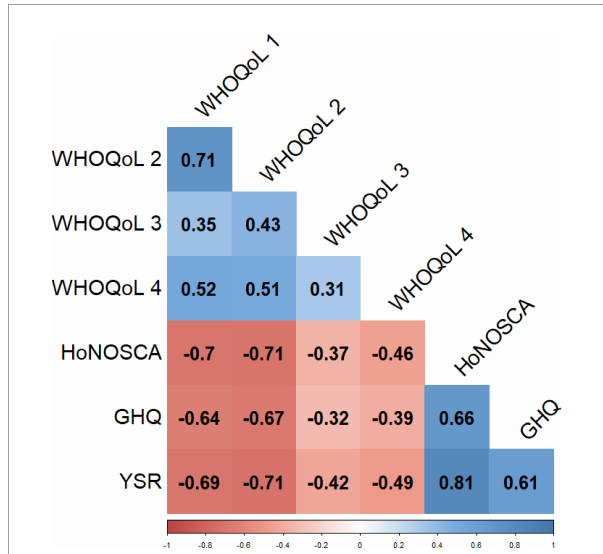
FIGURE3 Correlation matrix between WHO-QoL, HoNOSCA, GHQ, and YSR. Correlation coefficient, method = Spearman’s rho; all coefficients are bold because they are statistically significant ( p < 0.05). GHQ, General Health Questionnaire; HoNOSCA, Health of The Nation Outcome Scales For Children And Adolescents; WHO-QoL, World Health Organization Quality of Life (domains: (1) physical health, (2) psychological health, (3) social relationships, and (4) environment); YSR, Youth